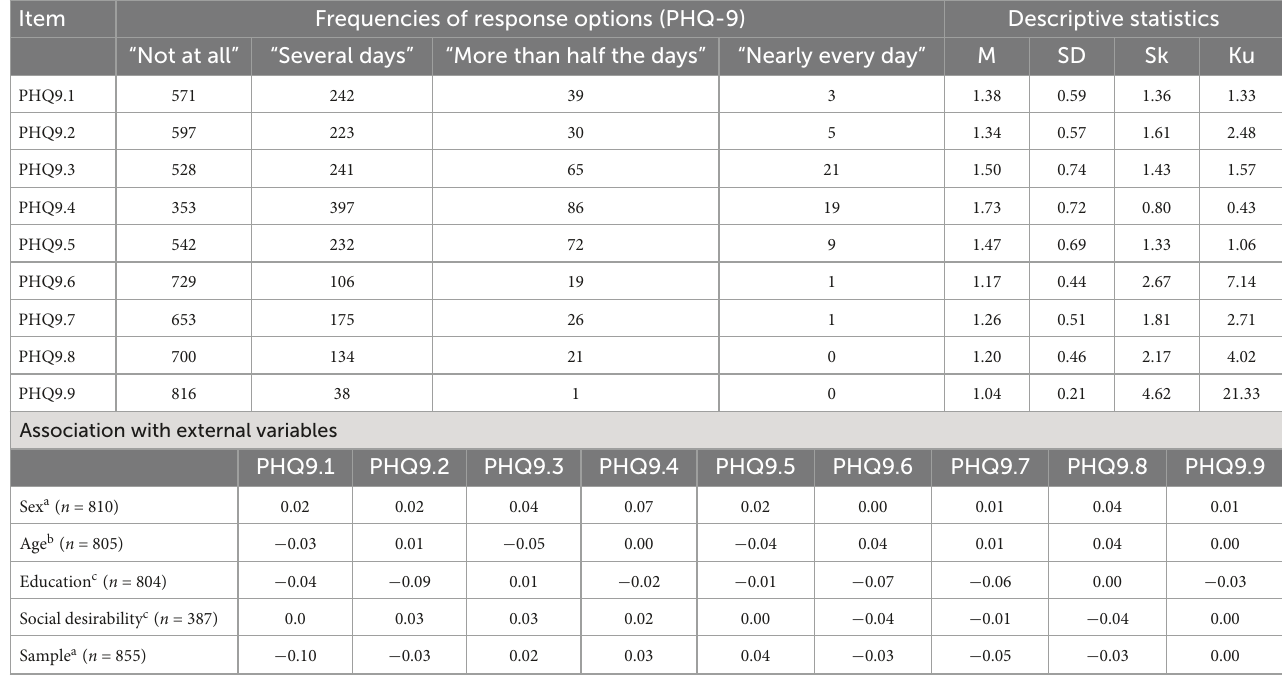
TABLE 3 Item univariate analysis ( n =